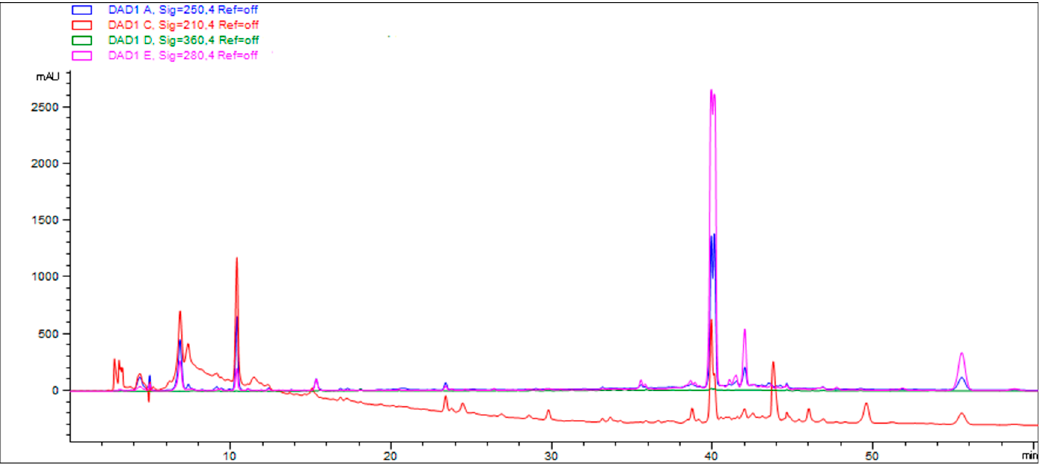
Figure 4. Analysis of the main compound of water and EtOAc fractions by HPLC.